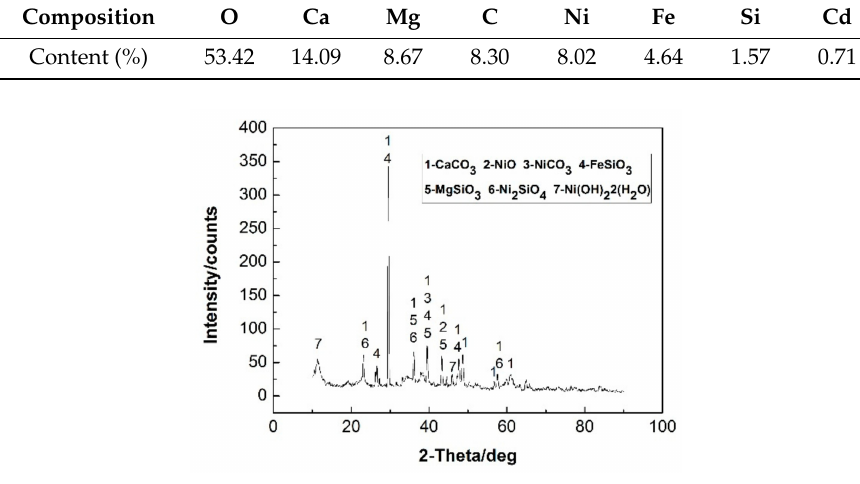
Figure 1. XRD pattern of the raw material.